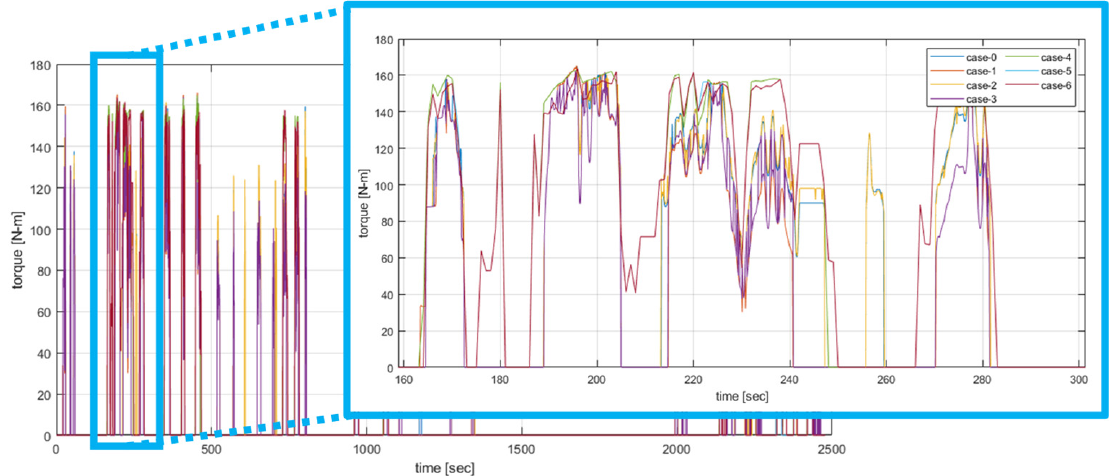
Figure 10. Comparison of DP results (2): engine torque.